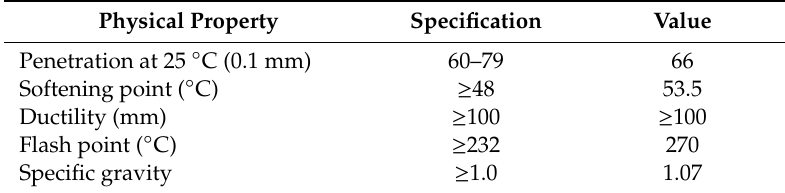
Table 1. Physical properties of asphalt penetration 60 / 70.